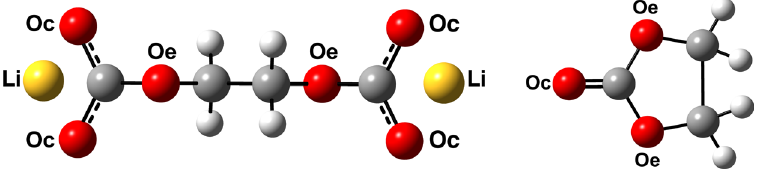
Figure 1. Chemical structure of Li 2 EDC (left) and EC (right) molecules. Carbon atoms are colored gray, hydrogens white, carbonyl (Oc) or ether (Oe) oxygen red, and Li + ions yellow. (Redrawn with permission from ECS Transactions 77, 1155–1162 (2017)) 13 .